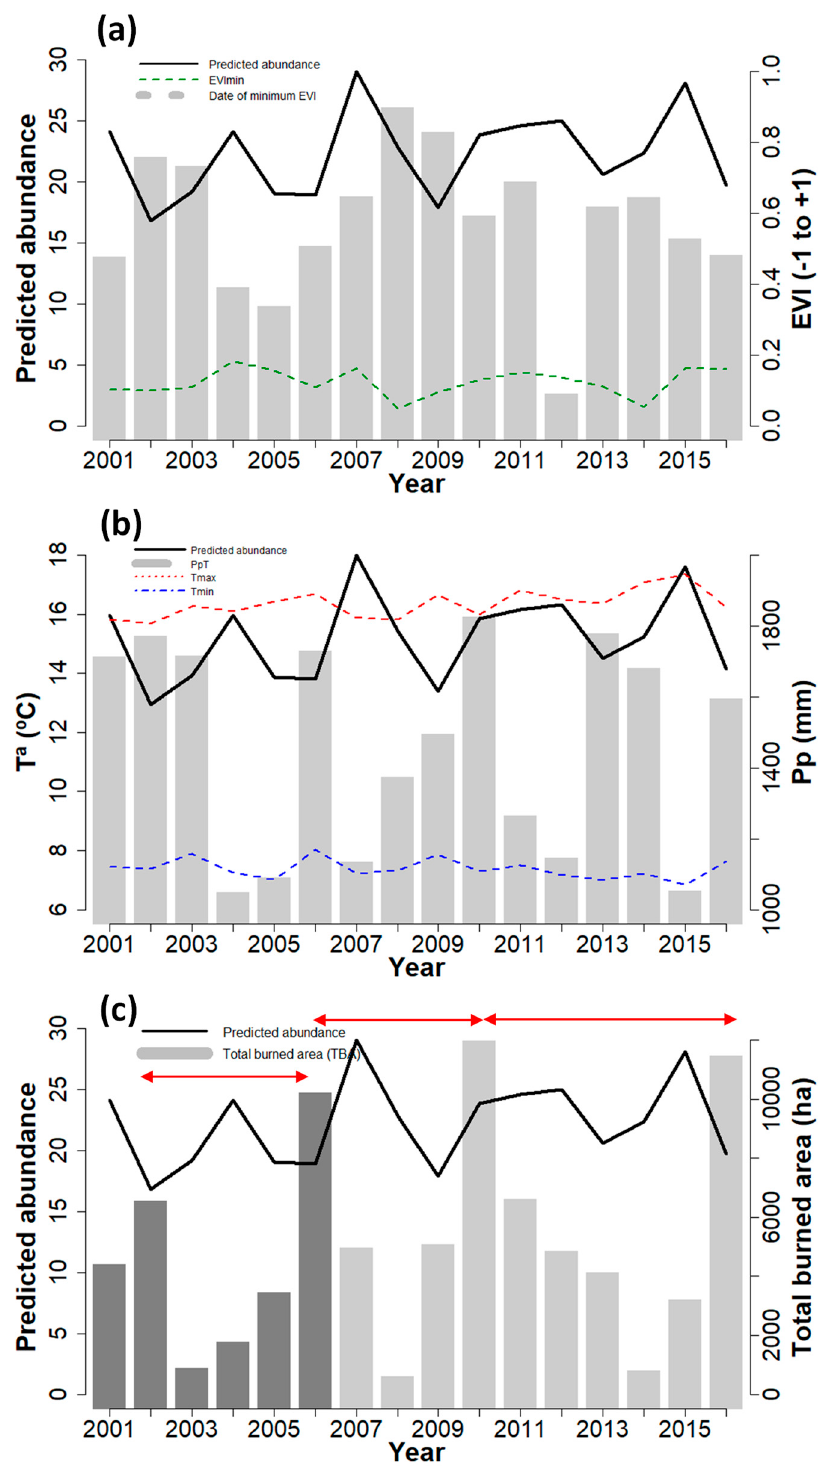
Figure 4. Yearly average values of predicted abundance of Iris boissieri (black line) in the study area for the time-period 2001–2016 against annual variables: ( a ) EFAs through EVI minimum (EVIm) and date of minimum EVI; ( b ) climate through total precipitation (Pp), maximum (Tmax) and minimum (Tmin) temperature; ( c ) total amount of burned area (TBA). Dark grey bars represent the calibration for the period 2001–2006. Red lines represent lag response of the species to fire events.